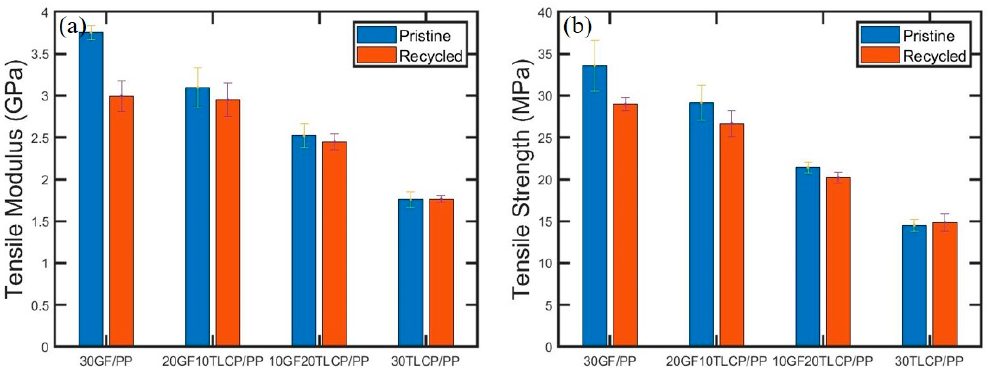
Figure 9. Tensile properties of hybrid composites in the transverse-to-flow direction. ( a ) Tensile modulus; ( b ) tensile strength.